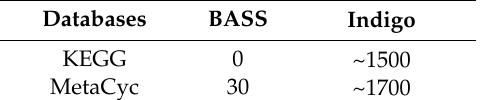
Table 3. Incomplete detection of aromatic substructures by BASS and Indigo.